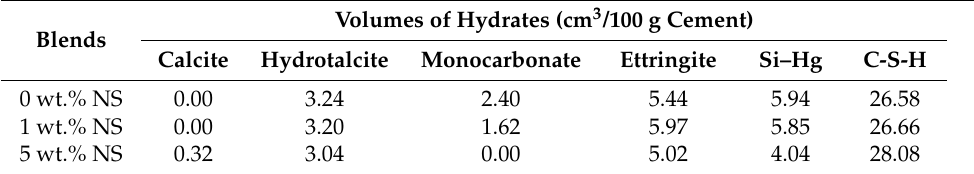
Table 3. Volumes of hydrates before exposure to